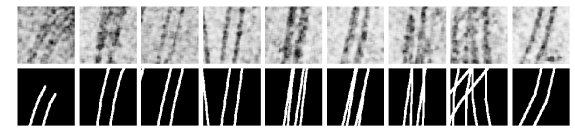
Figure 4. Exemplary un-augmented training